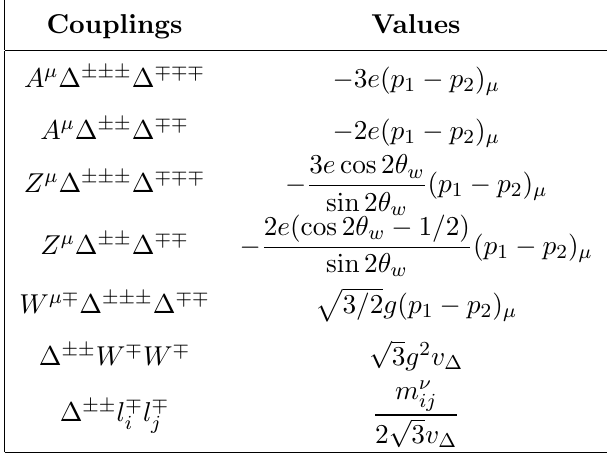
We have also computed the production of (cid:1) (cid:6)(cid:6)(cid:6) in association with a (cid:1) (cid:7)(cid:7) . Such